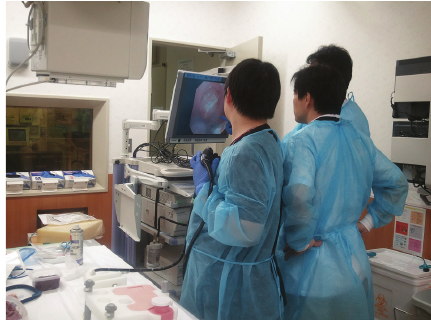
Figure 5: Hands-on training using the dry model. A trainee per- formed ES with the assistance of an experienced ERCP endoscopist.